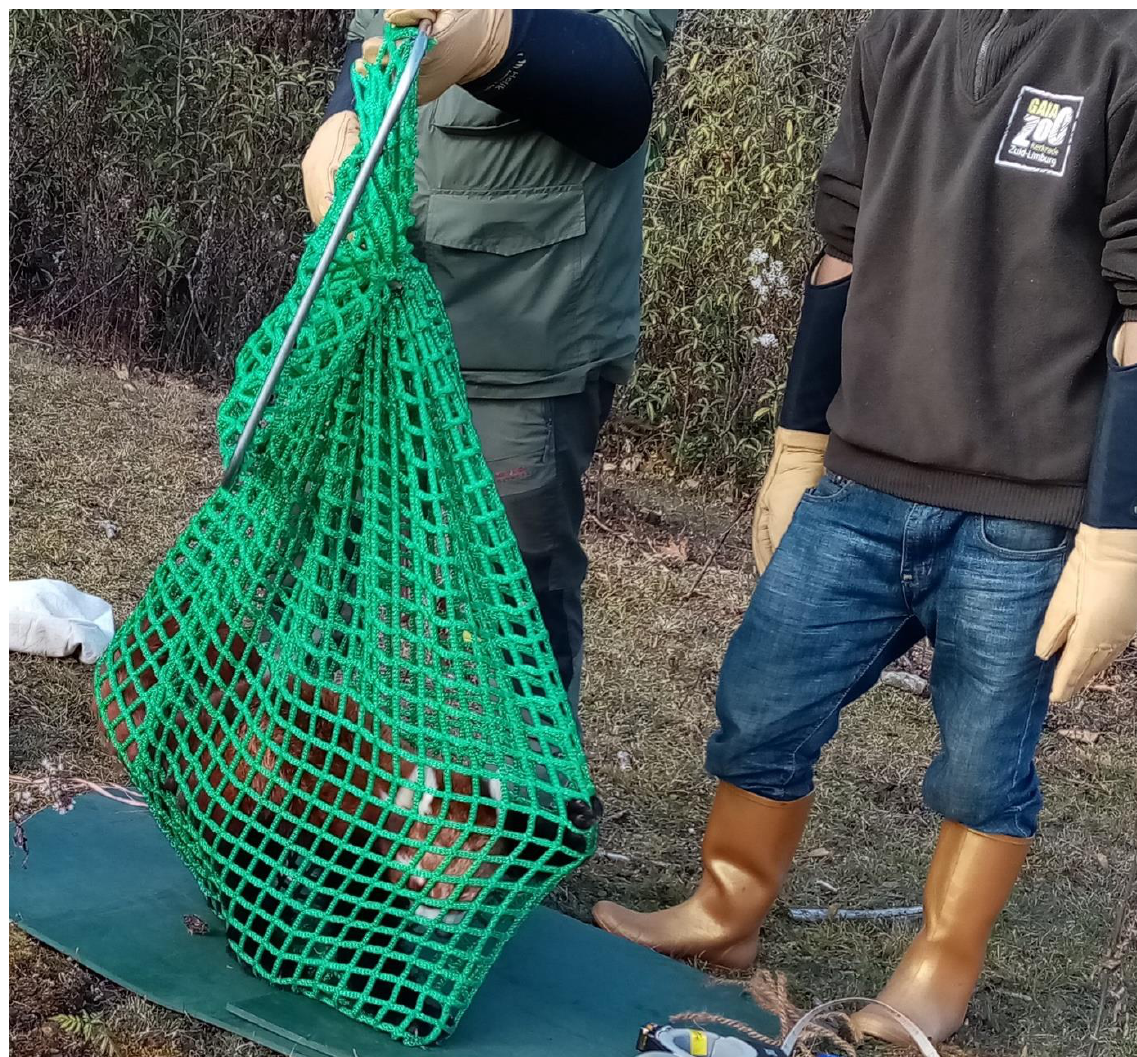
Figure 3. Net with a 1.5 m long handle was used to take the trapped animal out of the cage trap. The animal was taken out of this net after immobilization.